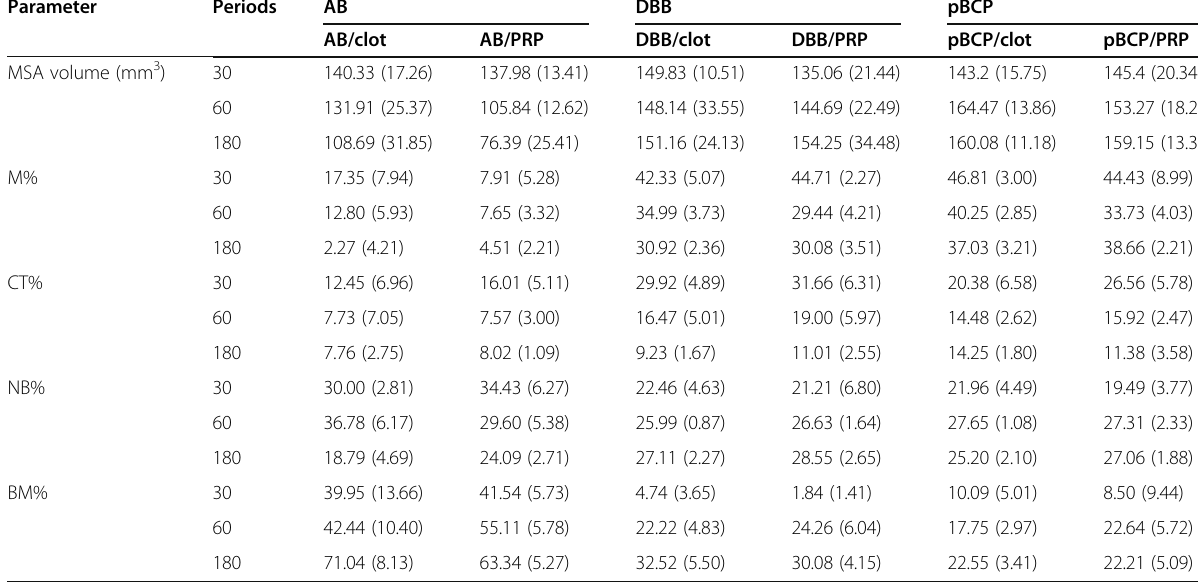
Table 2 Mean and standard deviation obtained for MSA volume and percentages of new bone (NB%), connective tissue (CT%), materials (M%), and bone marrow (BM%) for all groups and experimental periods